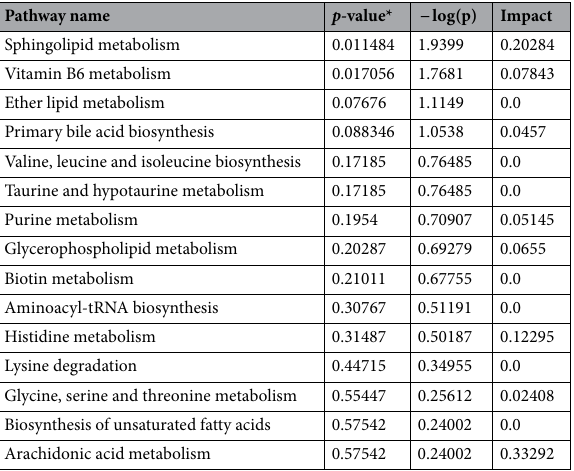
Table 5. List of biochemical pathways (MetaboAnalyst) identified in TRF and ETRF against HFD. The asterisk denoted significant value of p less than 0.05 ( p < 0.05) for statistical